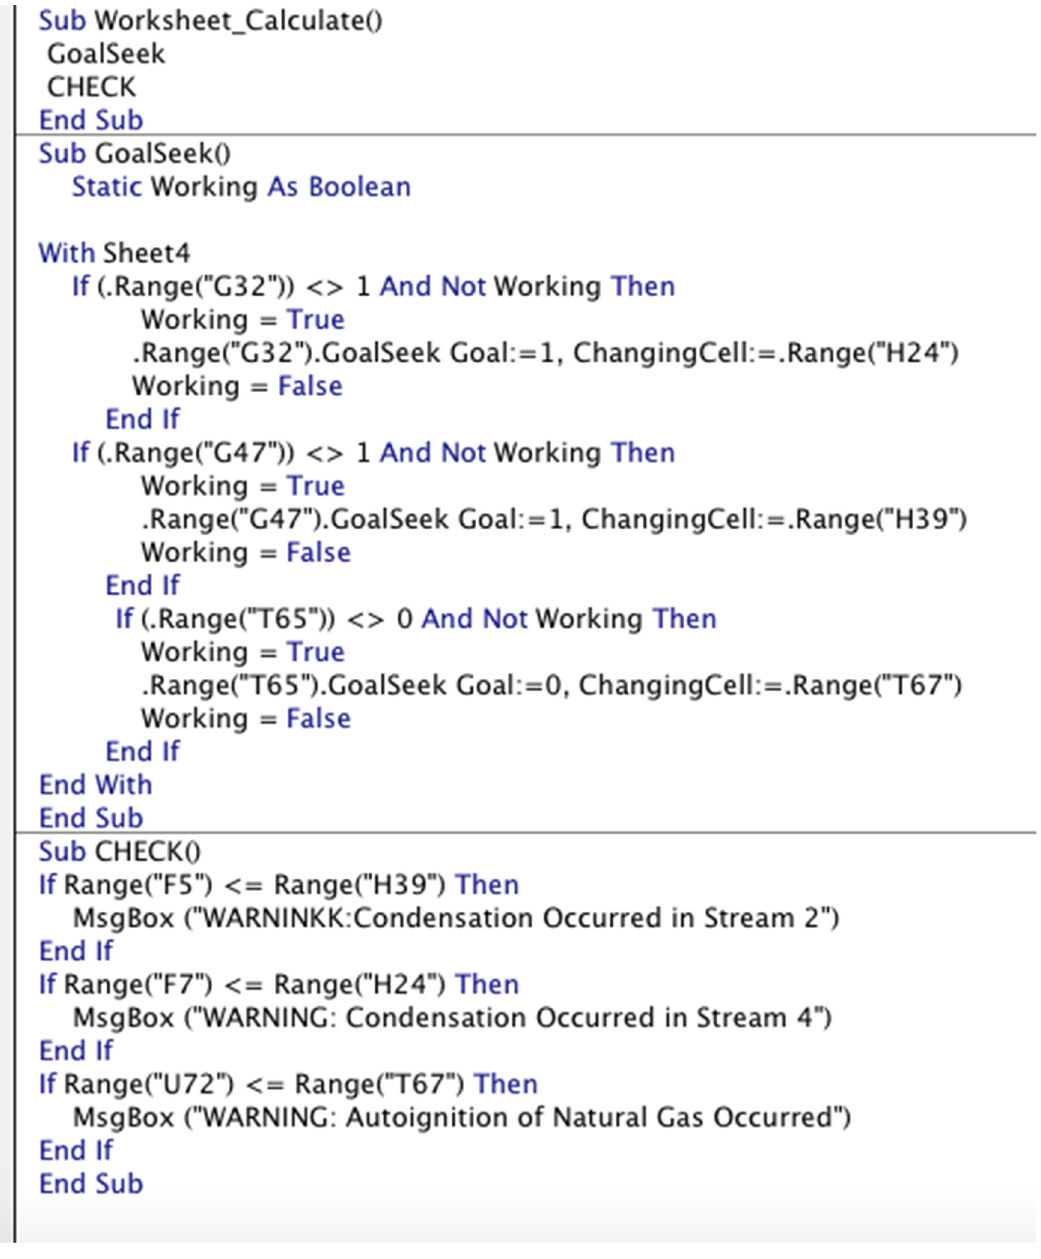
Figure A1. Auto goal-seek function in Visual Basic.